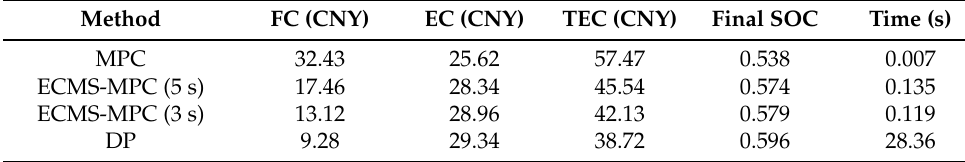
Table 4. Results of different controllers in the